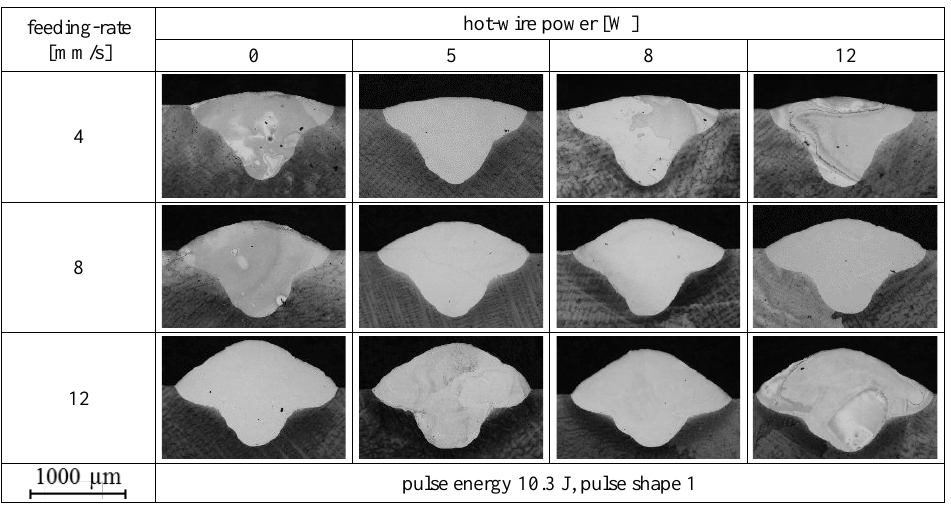
Figure 12. Influence of the hot-wire power and the wire-feeding rate on the weld seam geometry.